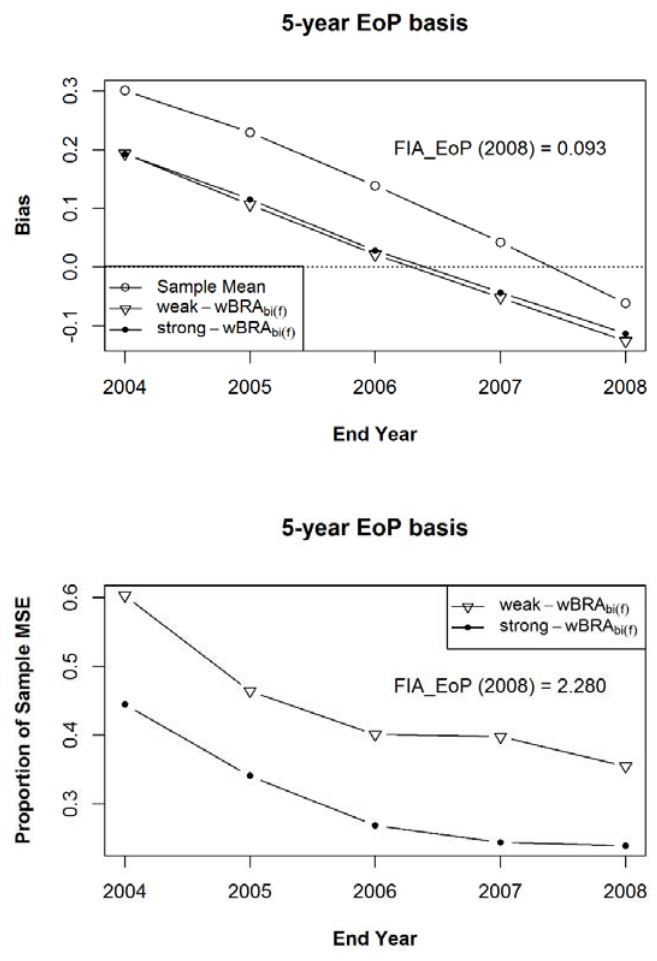
Figure 9. The simulation mean bias ( a ) and the mean of Mean Squared Errors (( b ), expressed as a proportion of the MSE of the sample mean) for Estimand 2 and the bias-adjusted EoP Estimator wBRA bi ( f ) (for years 2004–2008), using the weak and strong prior samples after 100 iterations of samples of size 1000 within the 125 populations of a composite sample of sample observation lengths of five, six, seven, eight, and nine years, in equal proportions.